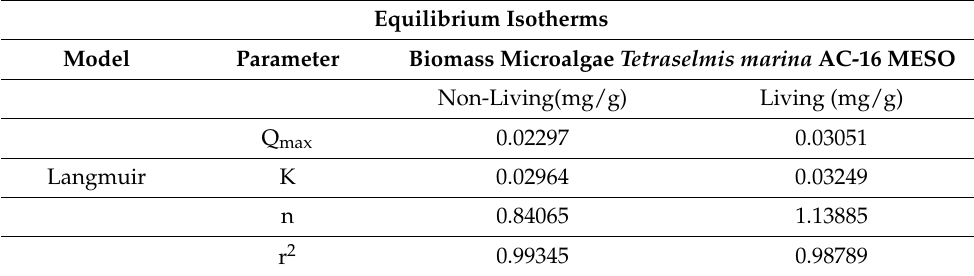
Table 1. Parameters from fitting the experimental results with equilibrium isotherm (Langmuir equilibrium isotherms)